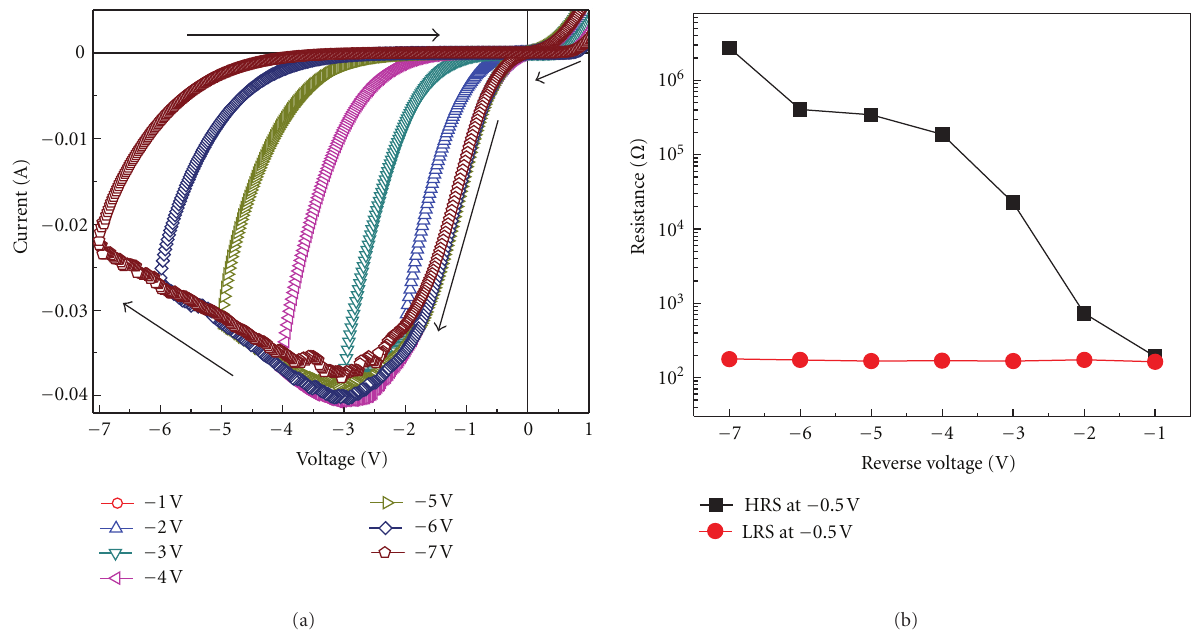
Figure 5: (a) The RS behavior after applying di ff erent reverse voltage from − 1 V to − 7 V. (b) The reverse voltage dependence of R HRS and R LRS .